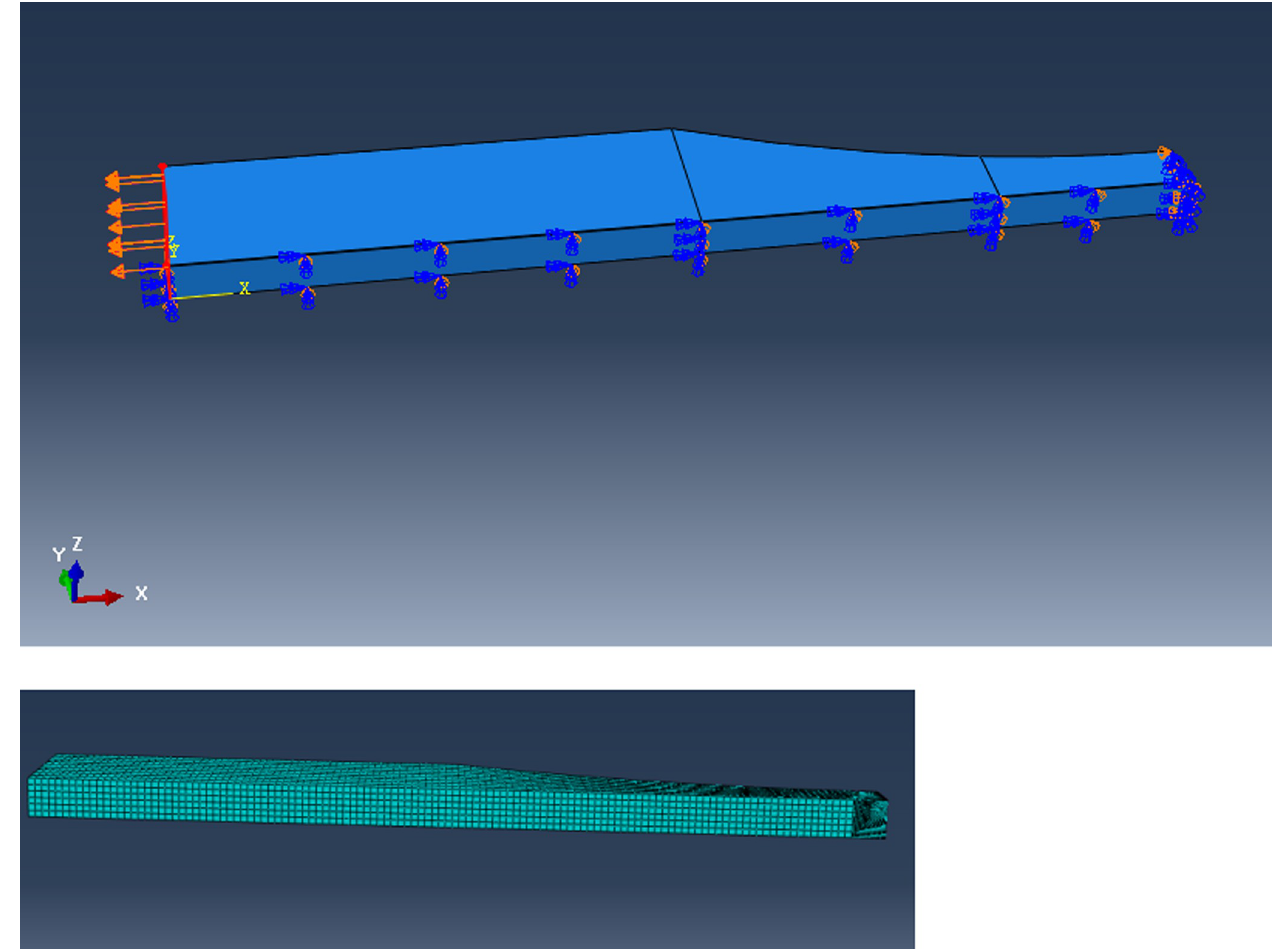
Fig 3. The model with surface roughness in ABAQUS.